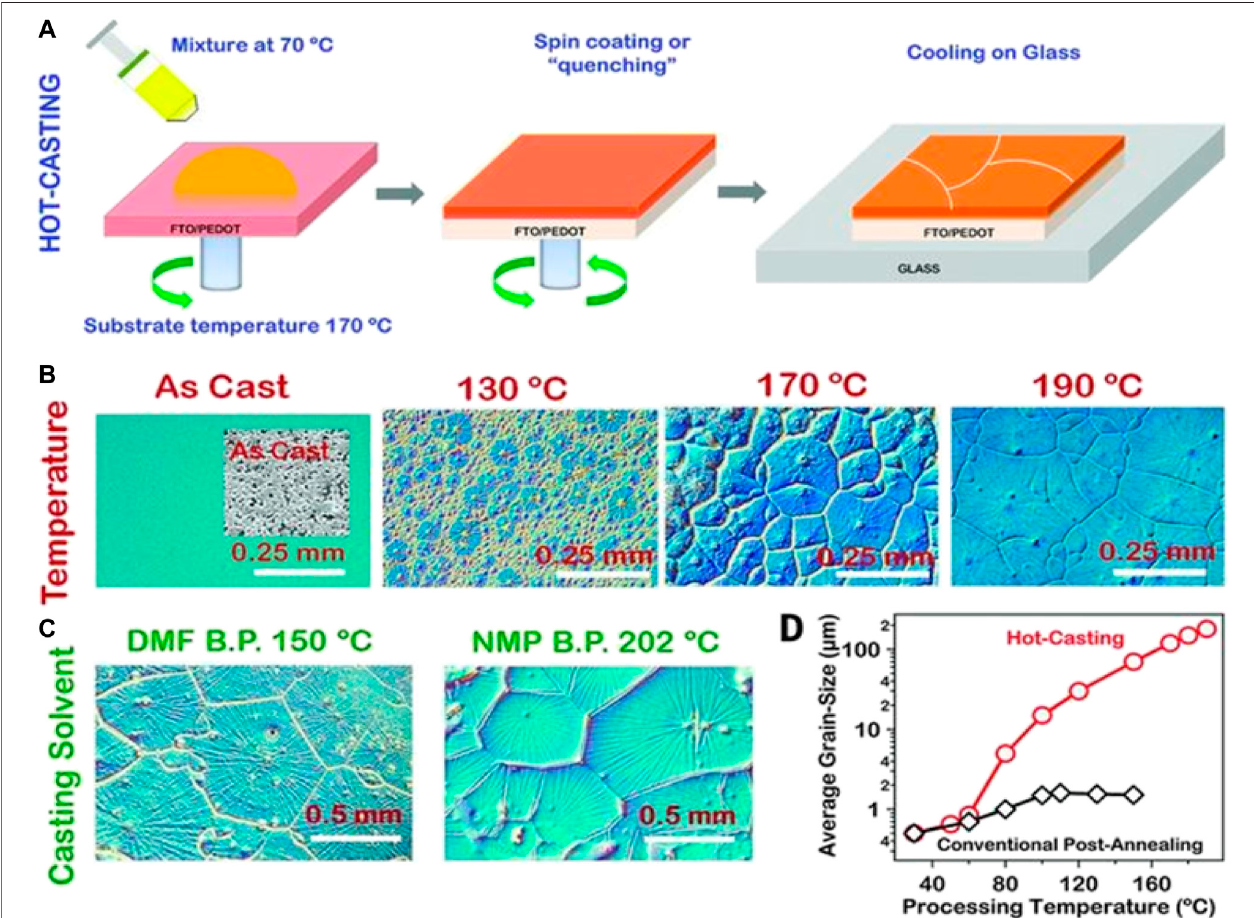
FIGURE1| Processingschemefortheperovskitethin fi lmusinghot-castingmethodsandobservationsforalarge-areamillimeter-scalecrystalgrainformationfora perovskite(PbCH 3 NH 3 I 3 – x Cl x ) – basedthin fi lm. (A) Hot-castingschemeforalarge-areacrystalgrowth[ITO,indiumtinoxide;FTO, fl uorine-dopedtinoxide;PEDOT:PSS, poly (3,4-ethylenedioxythiophene) polystyrene sulfonate]. (B) Optical micrographs illustrating the grain formation as a function of the substrate temperature with the castingsolutionmaintainedat70 ° C. (C) Large-areagrainformationusingthecastingsolventswithhighboilingpoints. (D) Comparisonofthegrainsizeasafunction of the processing temperature obtained for the hot-casting and conventional post-annealing methods. Reproduced with permission (Nie et al., 2015). Copyright 2015, American Association for the Advancement of Science.